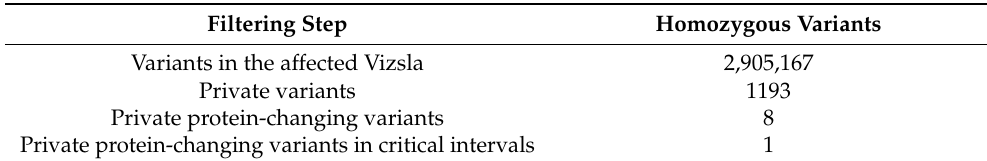
Table 1. Variant filtering results of the whole genome sequence from the affected Vizsla against 926 control genomes.